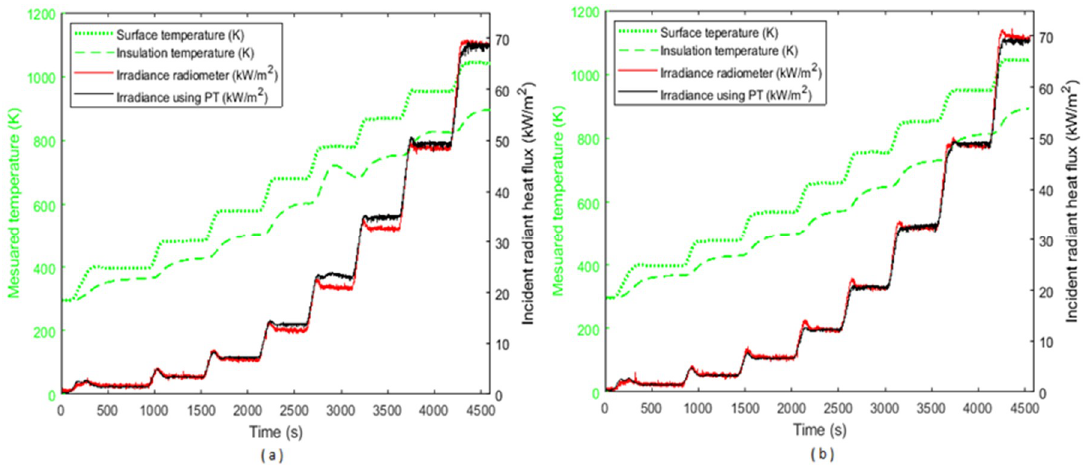
Figure 4. ( a ) Experiment results for unheated PT; ( b ) Experiment results for preheated PT.